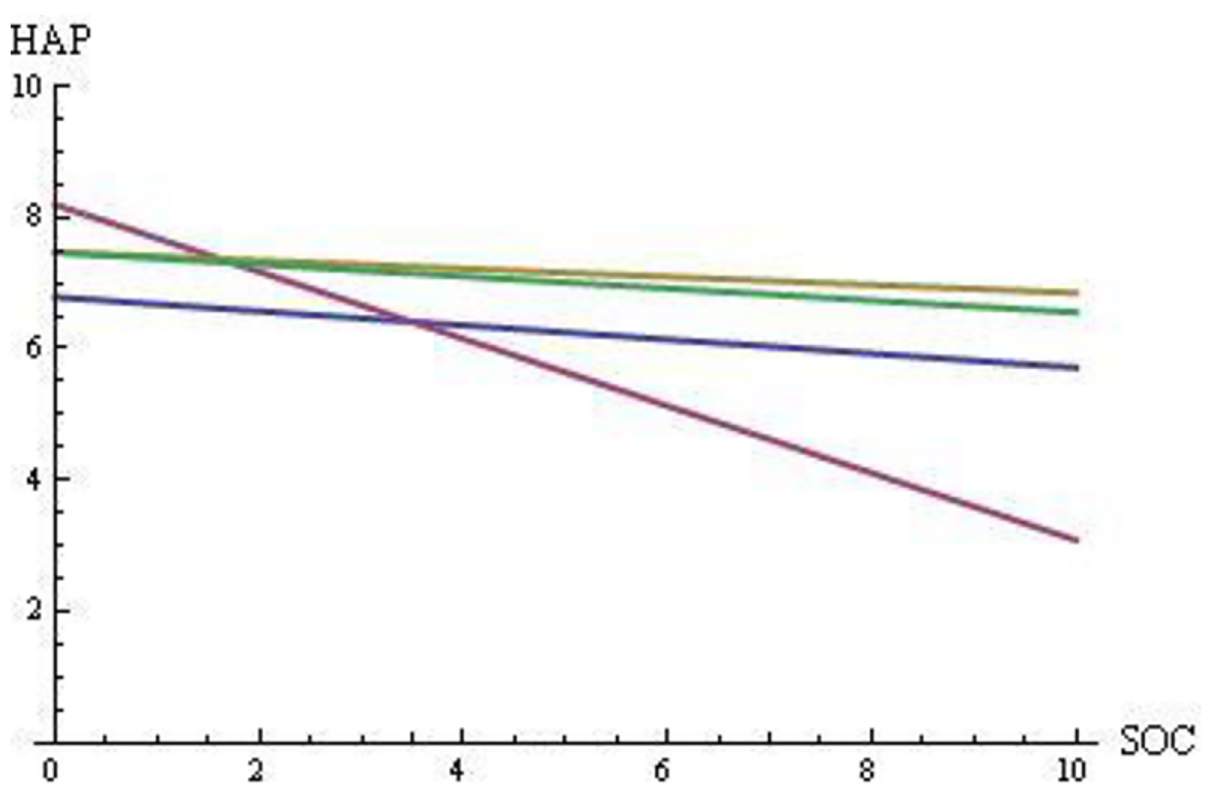
Fig 1. Social benefits (SOC) in [0, 10] vs. happiness (HAP) in [0, 10] if the relative contributions to happiness have values of α = 0.125, β = 0.75, and γ = 0.125. For composers (blue) CO: HAP = -0.107 SOC + 6.785; for painters (purple) PA: HAP = -0.511 SOC + 8.20; for mathematicians and physicists (yellow) MP: HAP = -0.062 SOC + 7.467; and for biologists and chemists (green) BC: HAP = -0.091 SOC +